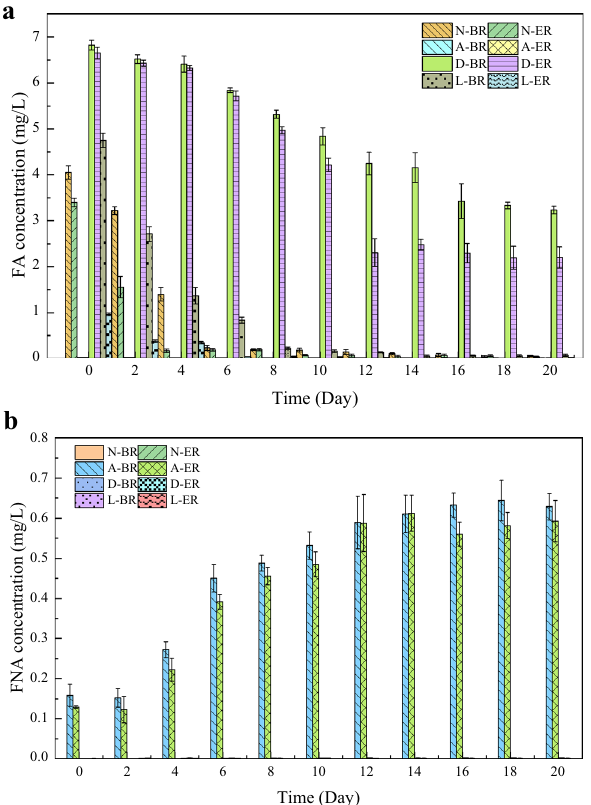
Figure 2. FA and FNA levels of four groups of activated sludge during operation. N normal group, A acid group, D DCD group, L low temperature group, BR blank reactor, ER experiment reactor. Error bars are defined as standard error of the mean (n = 3, biological